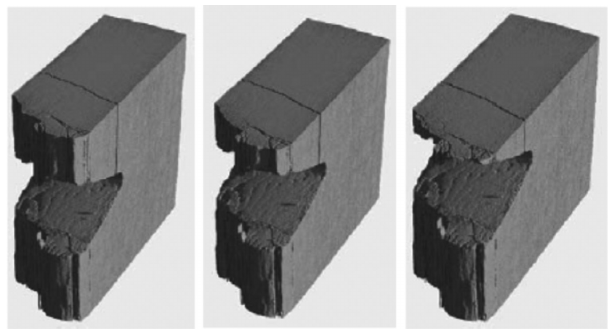
Fig. 10. Views for successive sectioning along the z axis at 3 intervals of 0.5 mm (after 250